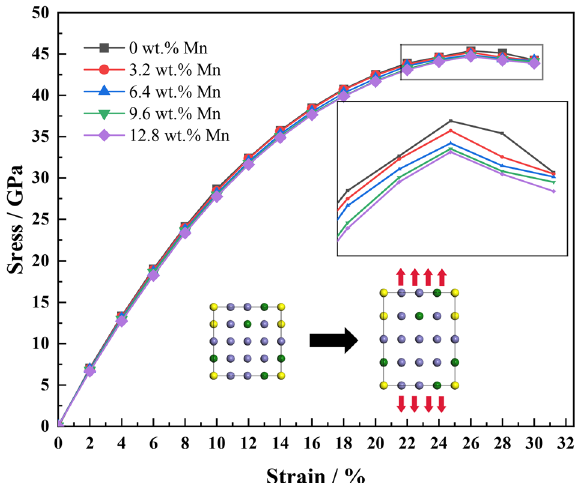
Figure 7. Ideal stress–strain curves of the five structural systems.